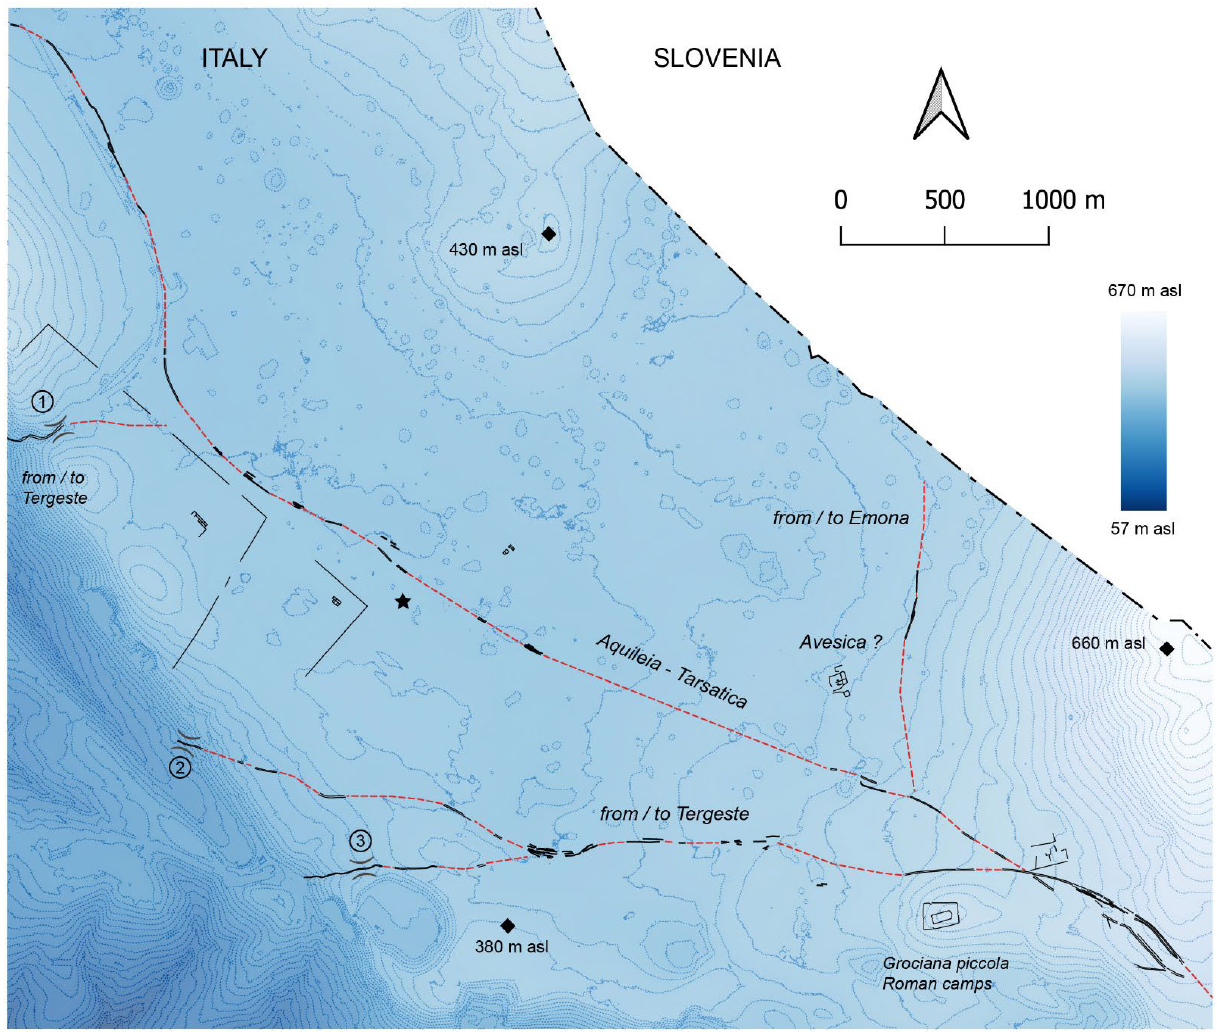
Figure 22. Reconstruction of Roman landscape with the road network and main archaeological sites.